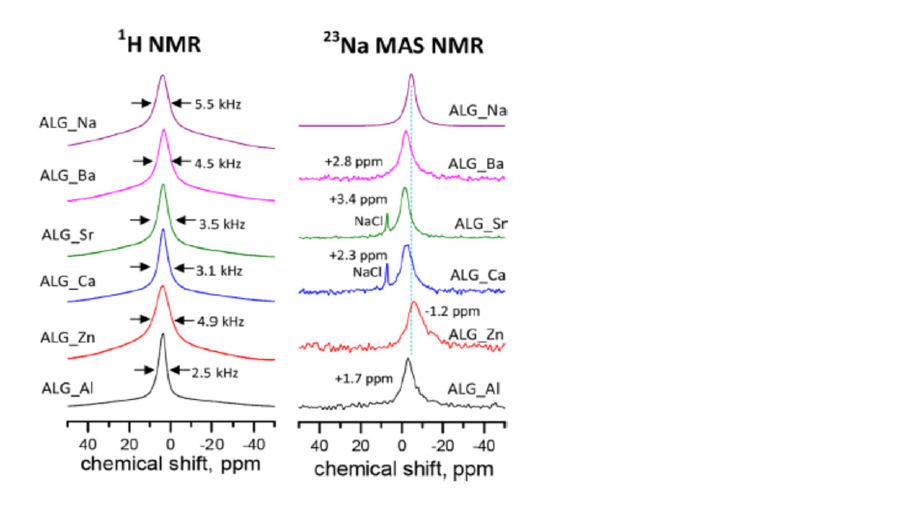
27 of 46 Figure 8. SEM micrographs of HG and LG metal-alginates aerogels. Reprinted with permission from [233] (Copyright 2012, American Chemical Society). All samples displayed porous tridimensional structures with interconnected pores, where slight differences in network density and fiber roughness were noticed. In conclusion, the macroscopic properties of transition metal cations-alginate gels are the result of structural peculiarities as the fibrillar structures entailed a rubbery behavior, while the complex structure, specific to entangled polymer chains, caused flowing behav- ior. Polyvalent ions (Ca 2+ , Zn 2+ , Al 3+ , Mn 2+ , Sr 2+ , Cu 2+ , and Ba 2+ ) cross-linked with alginate gels have been structurally investigated by the means of solid-state NMR spectroscopy, namely 1 H- and 13 C-NMR, 13 C CP/MAS NMR, 23 Na 3Q/MAS NMR, 2D 27 Al TQ/MAS NMR, and 2D 27 Al 3Q/MAS NMR, and density functional theory (DFT) calculus [216]. Experi- mental data confirmed the homogeneous distribution of cross-linking cations in the algi- nate gel microbeads and the high degree of ion exchange during cross-linking. A certain phase separation has been revealed in alginate gels, caused by the preferential localization of residual water molecules (5–10% wt) in the region of M units and carbonyl moieties, both phases coexisting and differing in their segmental motion. The mobile segments of alginate gels in hydrated domains are scarce, but they have high-amplitude motions (av- erage fluctuation angle up to 30°). It was possible to evidence the degree of ion exchange (Na versus polyvalent cations) by the means of 23 Na MAS NMR spectroscopy and by comparing the intensity of signals